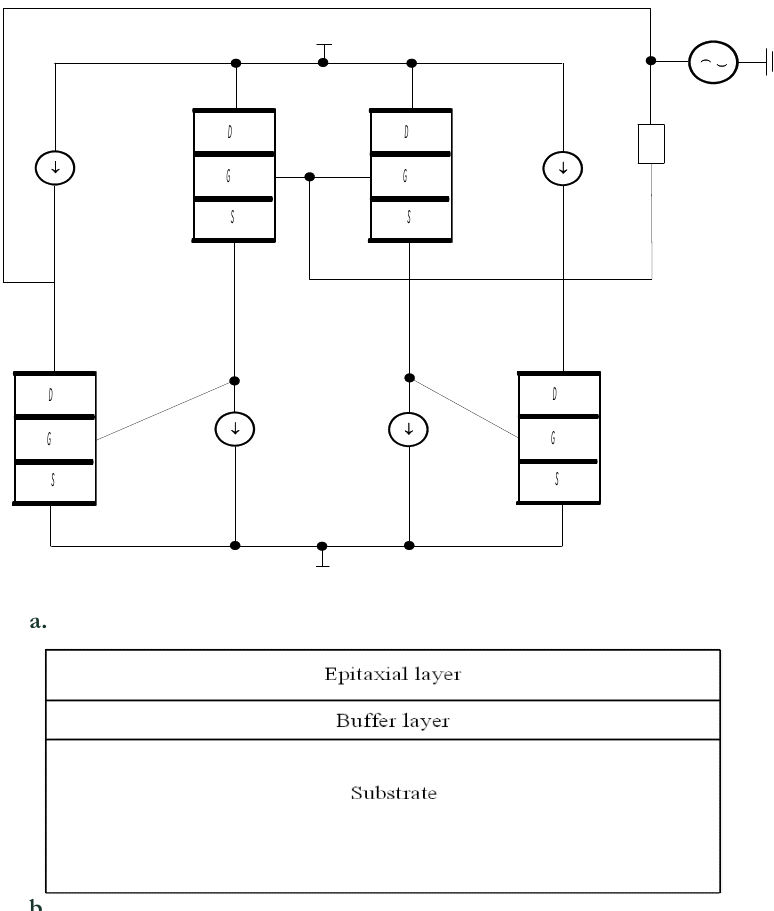
Fig. 1. C-multiplier; a. structure of the considered C-multiplier [19], b. heterostructure with a substrate, epitaxial layers and buffer layer (view from